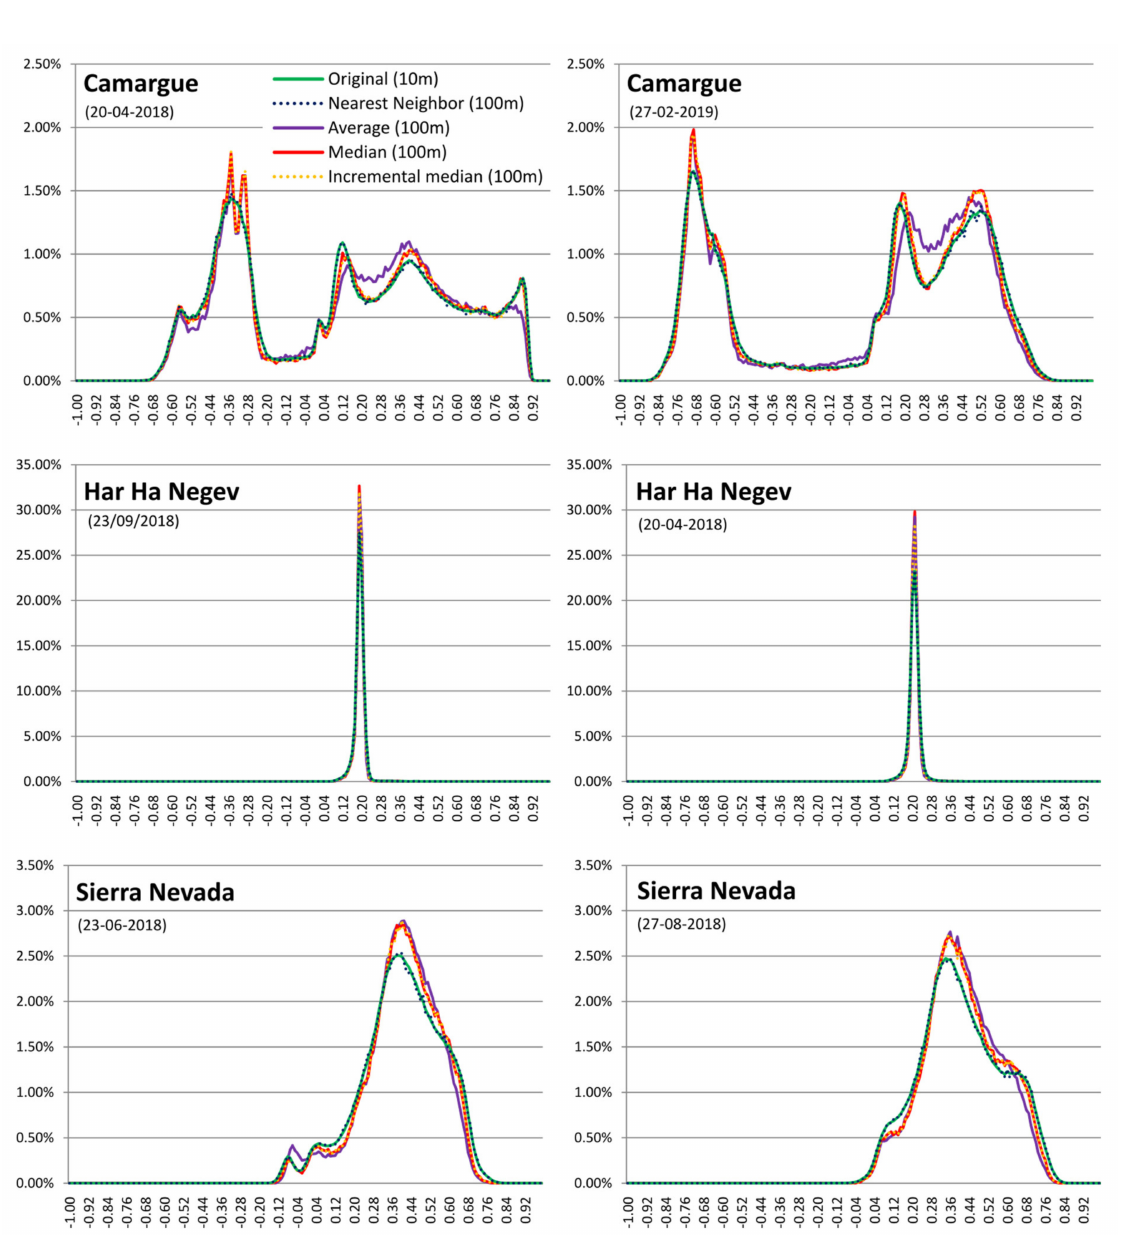
Figure 8. NDVI density functions for the two scenes studied for each protected area (side by side in columns) and for the protected areas Camargue, Har HaNegev and Sierra Nevada at original 10 m and 100 m resolutions using several resampling methods. All density functions have the legend shown in the first function, describing the resampling